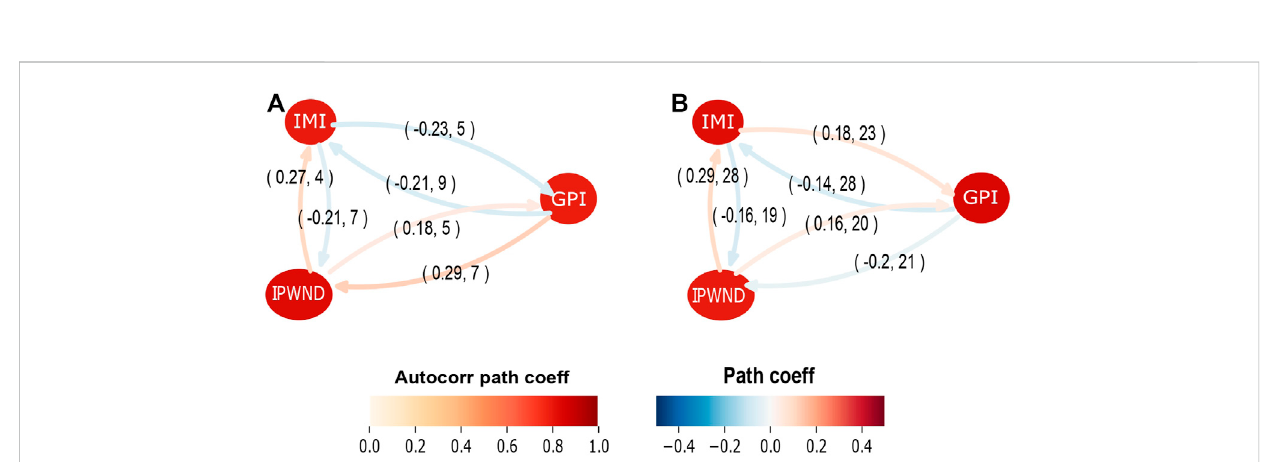
FIGURE 11 Causal network analysis among Indian Monsoon Index (IMI), WNP Genesis Potential Index (GPI) and Tropical Indo-Paci fi c wind index (IPWND) (A) HIST and (B) HISTNAT. The dark red circles around the three nodes (IMI, GPI and IPWND) indicate high auto-correlation path coef fi cient. The red links correspond to positive standardised regressionpath coef fi cients and the blue links correspond to negative standardised regression path coef fi cients and the arrows represent the direction of the link. The fi rst number in the bracket represents the maximum strength of the causal link expressed as standardised regression path coef fi cient and the second number correspondsto the lag with maximum strength. Only statisticallysigni fi cant causal links with p < 0.01 are